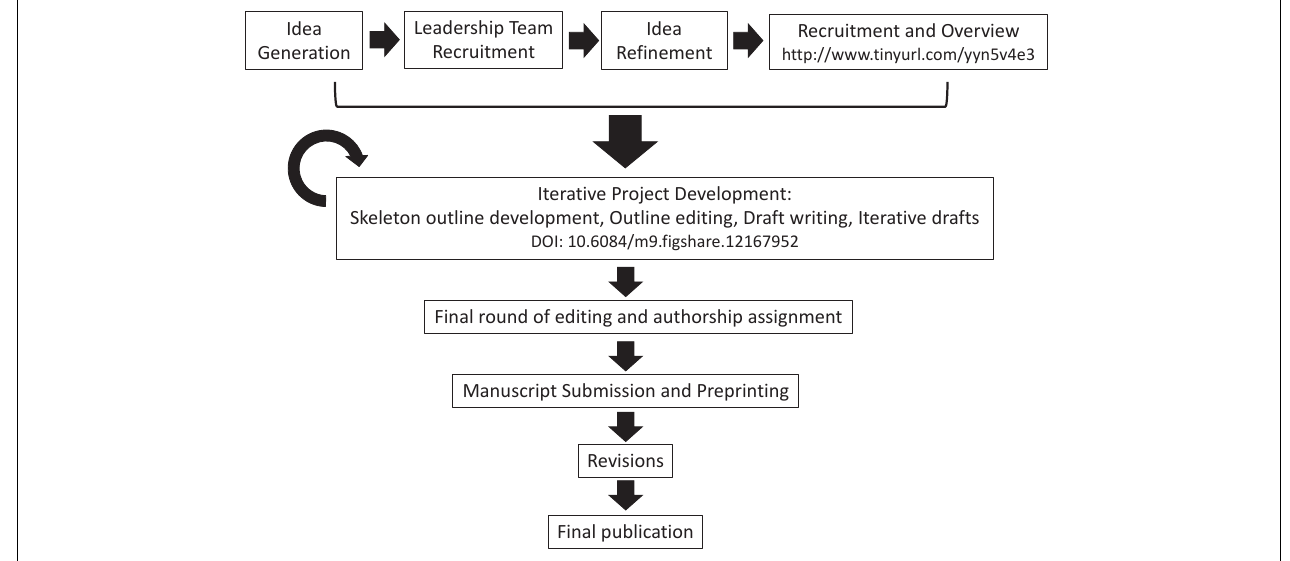
FIGURE 1 | Project Workflow. The project featured an iterative writing process between contributors recruited with an open call on Twitter and eight leadership team members. It progressed from conception to first submission in under a year. The entire process, coordinated via Google Docs, is depicted in a workflow video available with the doi: